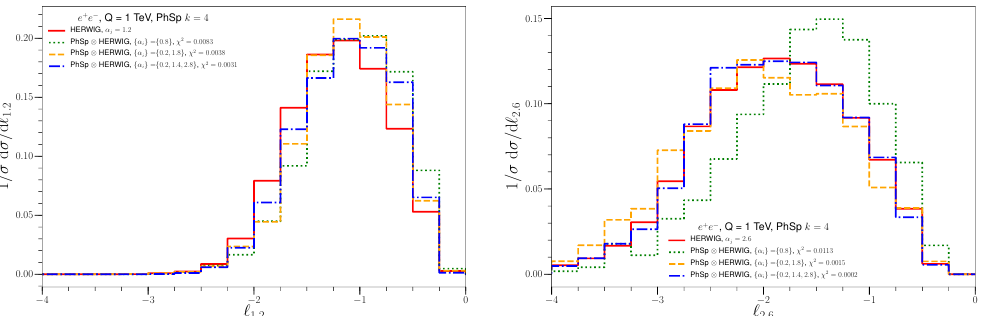
Figure 5 . Two examples of the reweighing procedure (with Herwig ) using the best n = 1 (green dotted), n = 2 (yellow dashed) and n = 3 (blue dot-dashed) angularities yielding the global minimum indicated for each case. The red curve shows the distribution obtained directly from Herwig 7. Left panel: the result for the (cid:11) j = 1 : 2 exponent. In this case n = 1 ; 2 ; 3 perform similarly. Right panel: the result for (cid:11) j = 2 : 6. A clear improvement can be observed here as n is